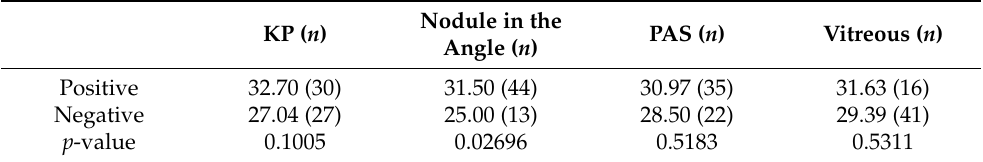
Table 4. Correlation of the max IOP (mmHg) with anterior segment manifestations and vitreous findings at the